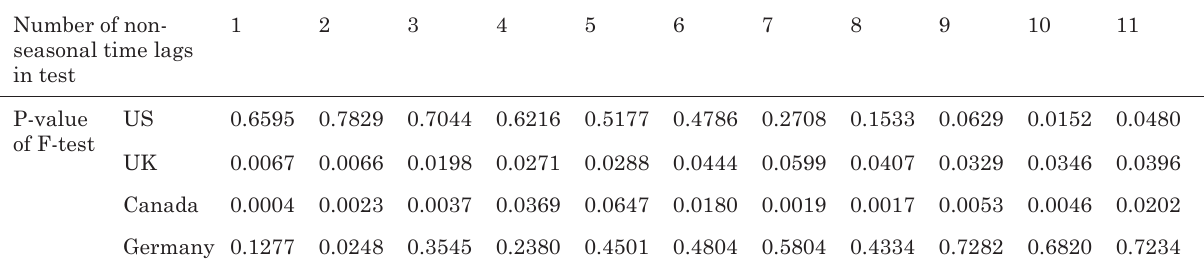
Table 2. The result of the Granger causality test Number of non- seasonal time lags in test P-value of